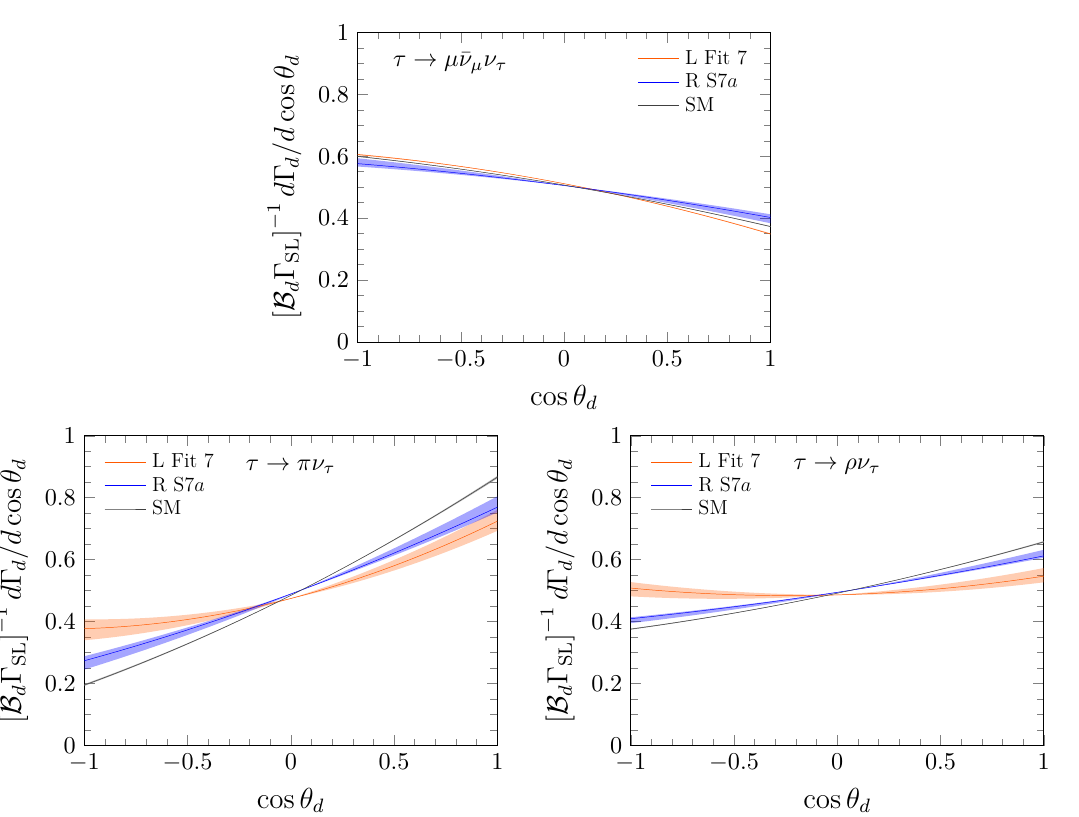
Figure 5 . Angular d Γ /d cos θ d distribution for the Λ b → Λ c τ ( µ ¯ ν µ ν τ , πν τ , ρν τ )¯ ν τ decays, keeping y = m d /m τ to its finite value, and obtained within the SM and the beyond the SM scenarios of Fit 7 (7a) of ref. [42] ([45]), which only includes left- (right-)handed neutrino NP operators. Error bands account for uncertainties induced by both form-factors and fitted Wilson coefficients (added in